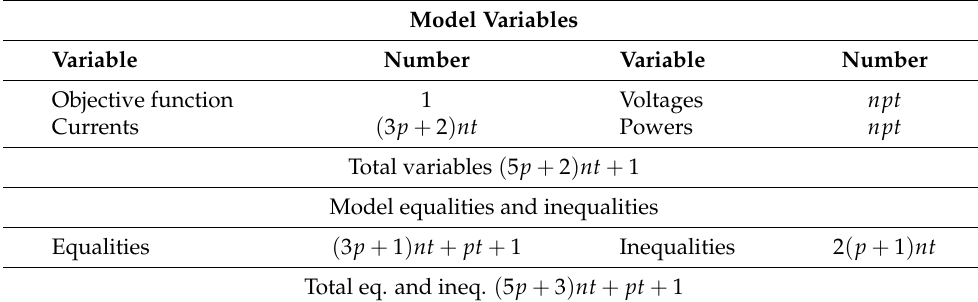
Table 1. Classification of the number of variables and equations for the optimization model